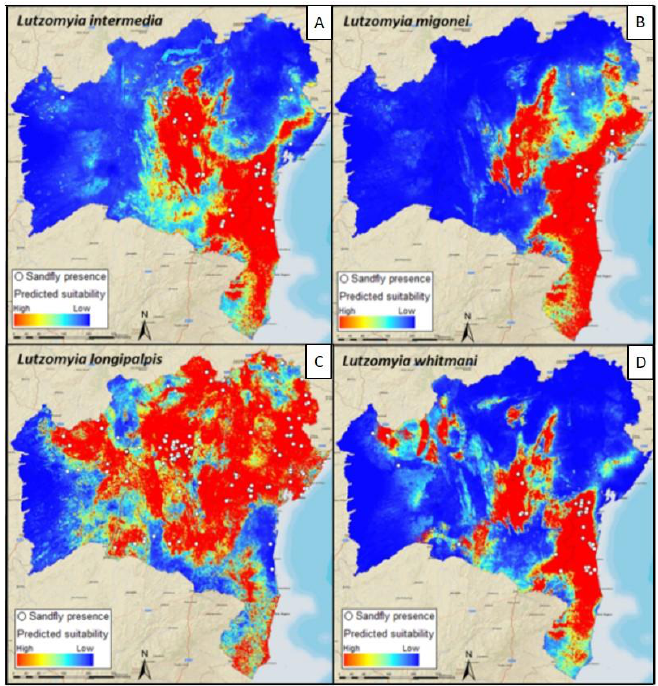
Figure 2. Maxent-predicted suitability for sand fly species of medical importance collected in Bahia state, Brazil. The output maps for the distribution of species incriminated as vectors of parasites that cause cutaneous leishmaniasis ( A , B , D ) and visceral leishmaniasis ( C ) were based on MODIS vegetation indices and Bioclim variables. Red areas indicate a higher suitability for vector occurrence.